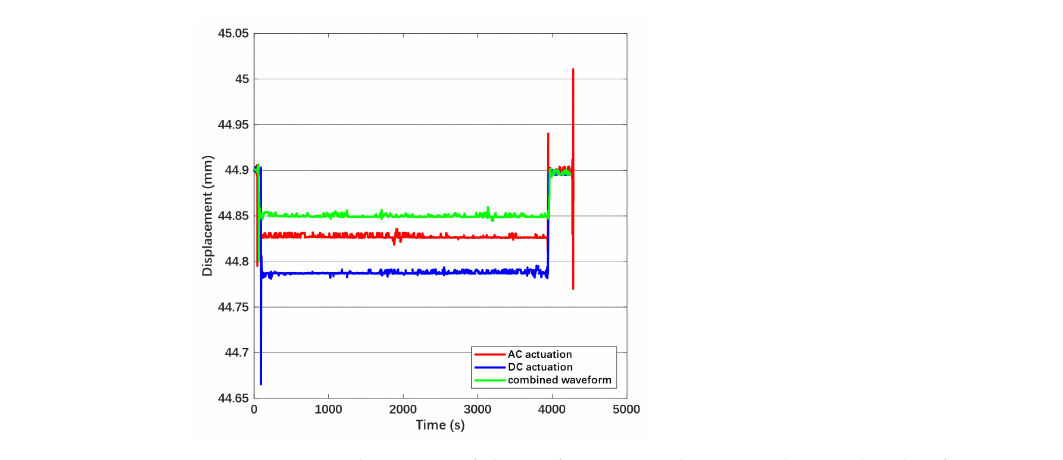
Figure 19. Displacement of the wafer in time domain. The amplitude of DC actuation and the combined waveform is 80 V and the amplitude of AC actuation is 143 V. The coefficient n is set as 1.67.